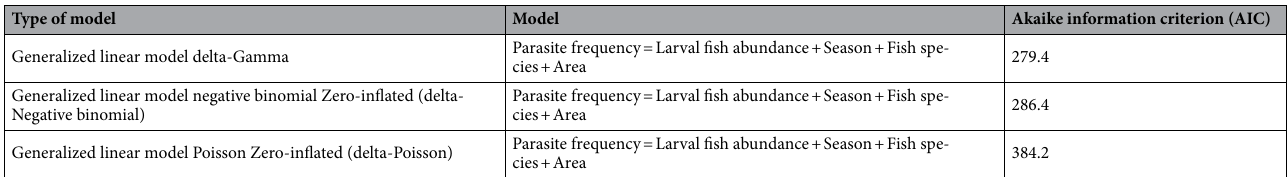
Table 3. Selection of the most informative model (using the Akaike information criterion) to explain the variability of the frequency of parasitized fish larvae species considering as predictors the variables larval fish abundance, season (Spring–Summer and Autumn–Winter), fish species ( H. cunninghami , A. crinitus , G. marmoratus , Myxodes sp., O. jenynsi ), and area (Isla Santa María and Punta